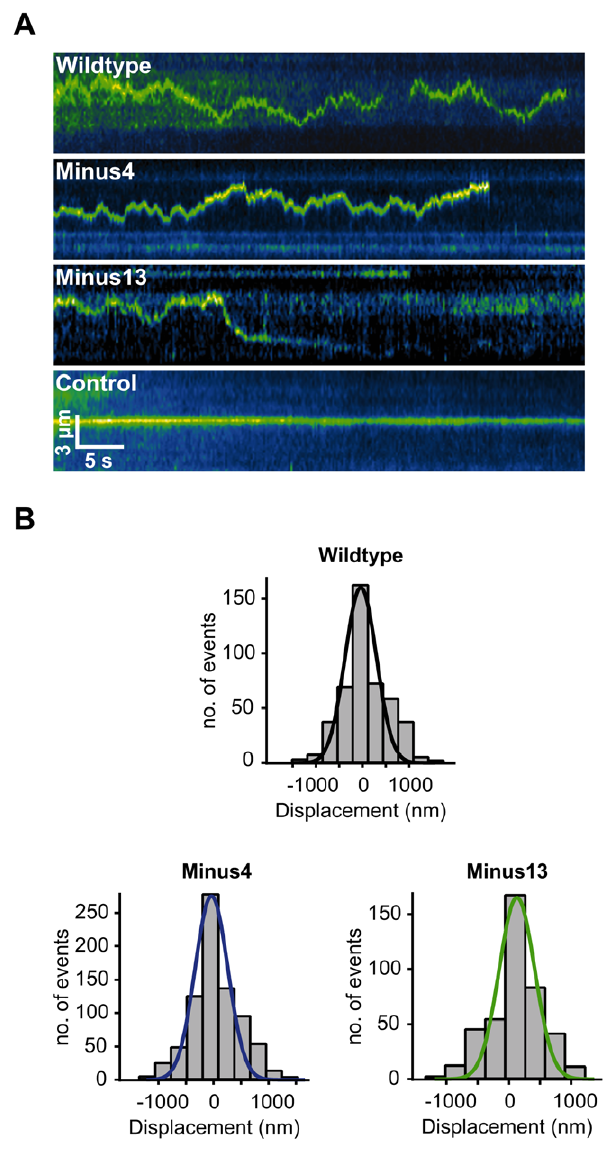
Figure 3. One-dimensional diffusion of myosin V loop 2 constructs on microtubules. (A) Kymographs of sequential frames depicting diffusive movement of single Cy3-labeled myo V Wildtype , Minus4 and Minus13 molecules (top to bottom, pseudo-colored green) on Atto488-labeled microtubules in 25 mM KCl. Microtubules are not shown for this purpose. Control represents a stationary, non-diffusing motor molecule on the microtubule. (B) TIRFM movie sequences of single myo V molecules on microtubules in 25 mM KCl were analyzed and then plotted as a displacement histogram. A single Gaussian (solid color-coded lines) was fitted to the data using equation 1 (Methods). From the obtained fit, the variance s was used to calculate the diffusion coefficient D according to the equation, D = s /2 t , where t is the time interval between images, resulting in D Wt =0.113 m m 2 /s (n=464), D Minus4 =0.089 m m 2 /s (n=801) and D Minus13 =0.081 m m 2 /s (n=425). Black, blue and green color-coded fit-lines depict the Gaussian fit for the individual displacement distribution of myo V Wildtype , Minus4 and Minus13 ,